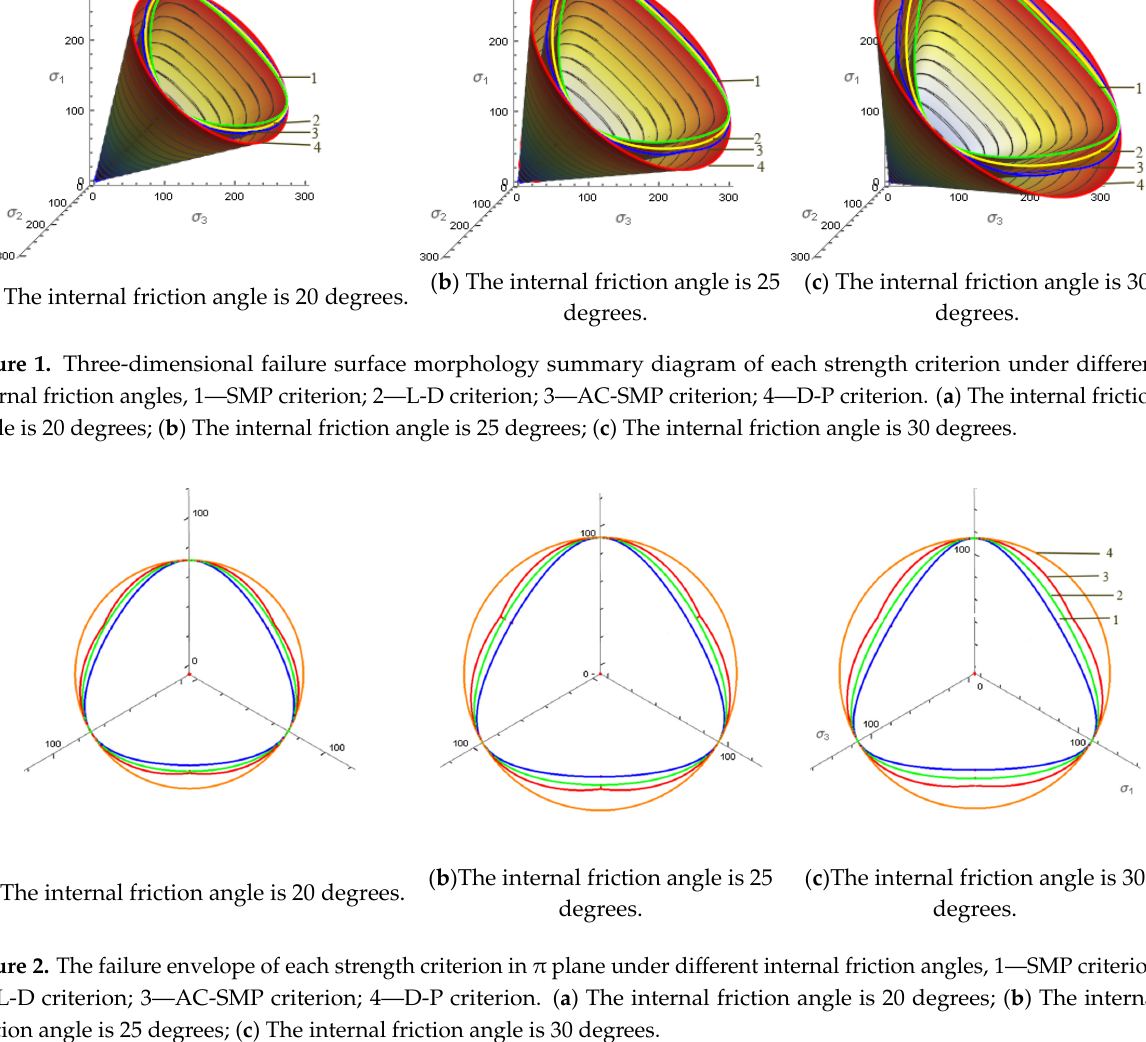
Figure 1. Three-dimensional failure surface morphology summary diagram of each strength criterion under different internal friction angles, 1—SMP criterion; 2—L-D criterion; 3—AC-SMP criterion; 4—D-P criterion. ( a ) The internal friction angle is 20 degrees; ( b ) The internal friction angle is 25 degrees;( c ) The internal friction angle is 30 degrees.